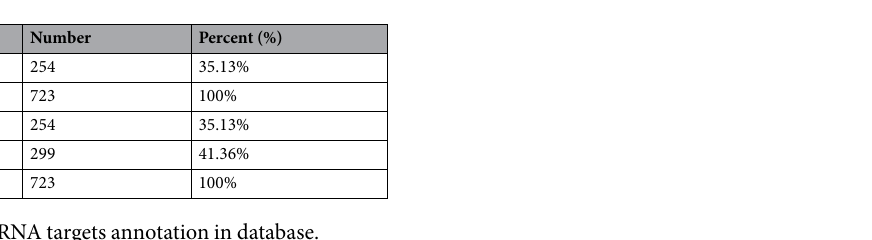
Table 1. MiRNA targets annotation in